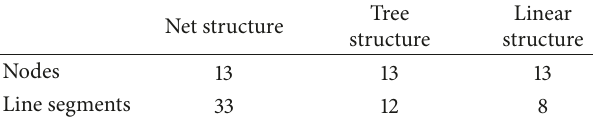
Table 2: Complexity of three information structures.